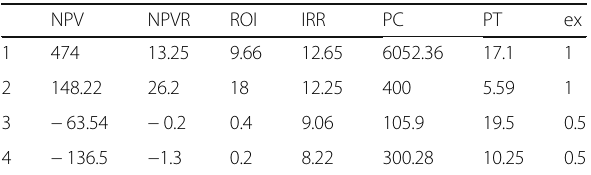
Table 1 A part of the training samples